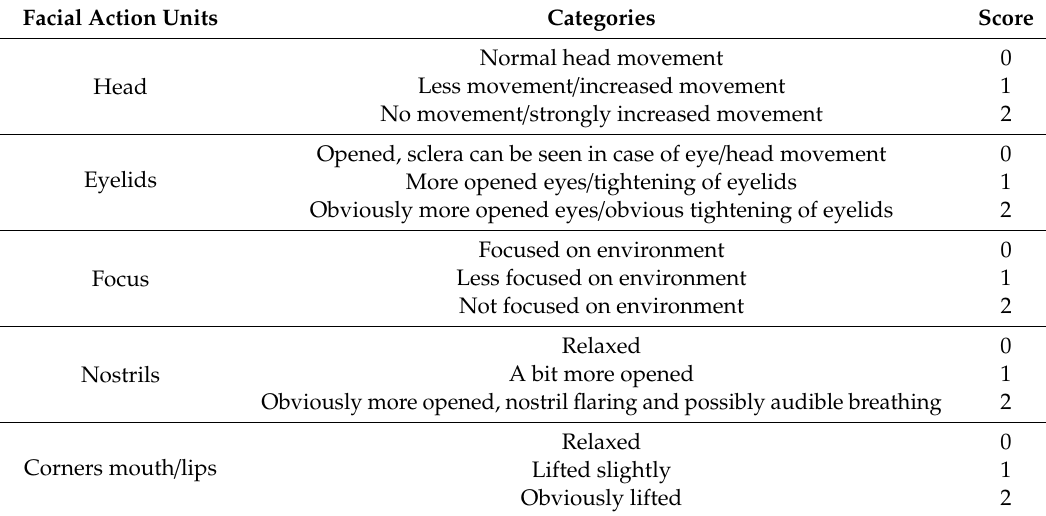
Table 2. Score sheet of the Equine Utrecht University Scale for Facial Pain Assessment for foals (EQUUS-FAP